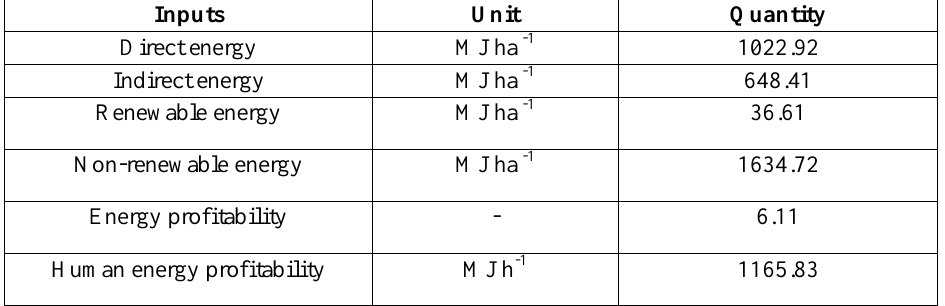
Table 6. Energy parameters for sunflower production in the mechanized schemes eastern Sudan